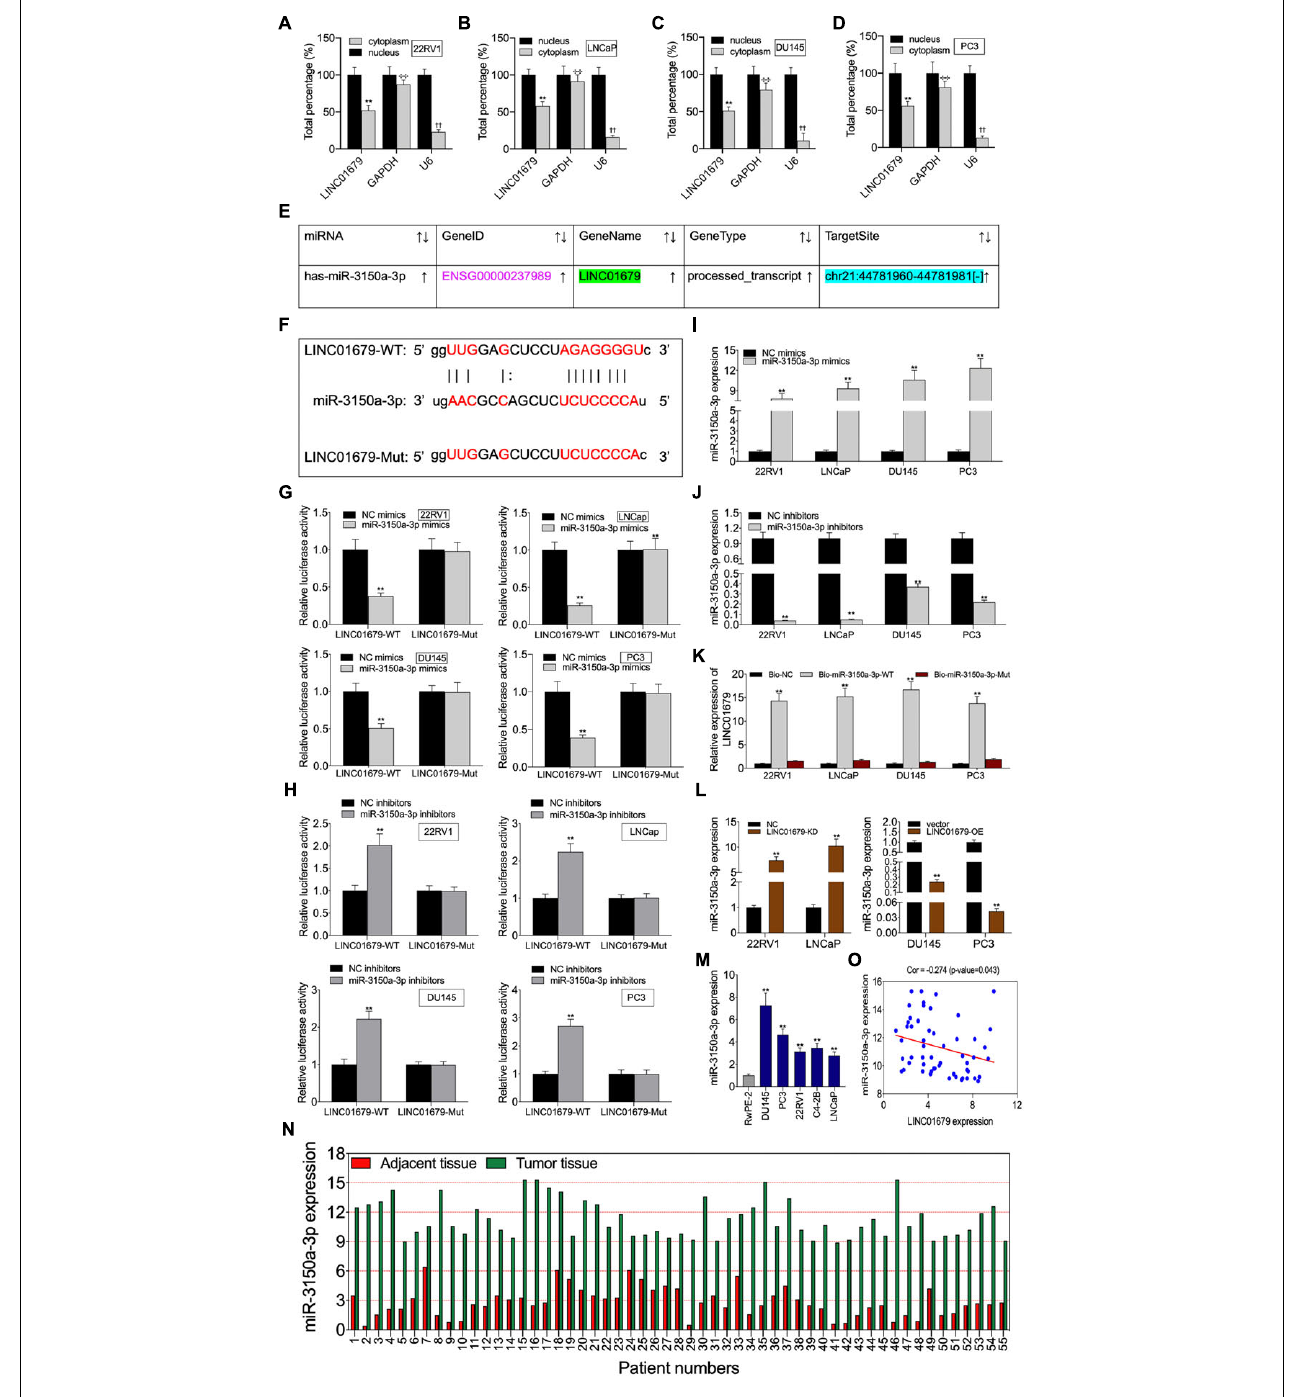
FIGURE 5 | LINC01679 acted as a sponge of miR-3150a-3p in PCa. (A–D) Nuclear–cytoplasmic fractionation was performed to investigate LINC01679 expression in the cytoplasm and nucleus of PCa cells. (E) miR-3150a-3p was predicted as a potential target of LINC01679 by the starBase website. (F) Specific binding regions between LINC01679 sequence and miR-3150a-3p sequence analyzed by the online analysis software. (G,H) Binding of LINC01679 to miR-3150a-3p verified by dual-luciferase reporter gene assay. (I,J) miR-3150a-3p expression in PCa cell lines after miR-3150a-3p mimics/or inhibitors treatment determined by qRT-PCR. (K) Dramatic enrichment of LINC01679 was detected in biotinylated miR-3150a-3p by RNA pull-down assay. (L) LINC01679 expression after siRNA-LINC01679 or LINC01679-expressing vector treatment determined by qRT-PCR. (M,N) LINC01679 expression in PCa cell lines and patients measured by qRT-PCR. (O) Spearman correlation analysis between LINC01679 expression and miR-3150a-3p expression. The experiment was repeated thrice independently; ** vs. NC or vector group, p < 0.01; (cid:67)(cid:67) vs. nucleus (GAPDH) group; †† vs. nucleus (U6) group.